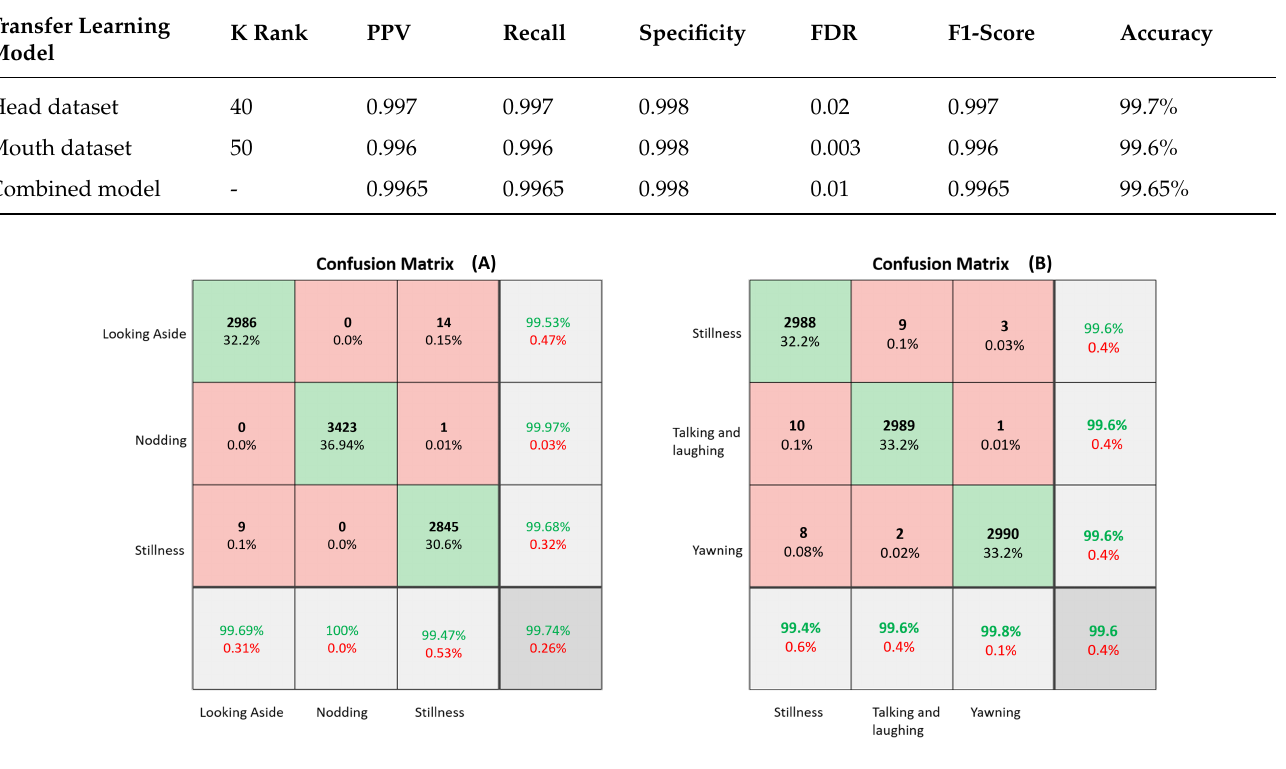
Figure 13. Confusion matrices of the feature extraction model for ( A ) the head position dataset and ( B ) mouth movement